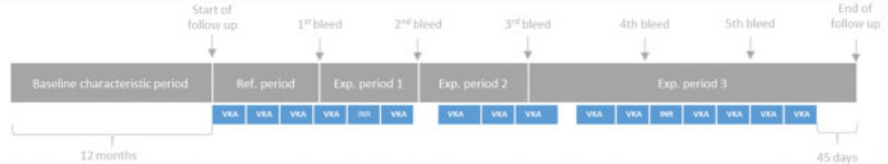
Fig. 1 Schematic description of study design. Individuals are followed up from their fi rst VKA prescription until discontinuation of VKA treatment (unless the study period ends, the individual leaves the database, or the individual dies before discontinuing treatment; not shown). In the analysis the risk of primary and secondary outcomes within each of exposure periods 1 to 3 (de fi ned by the number of bleeds that has occurred; 1, 2, or (cid:1) 3) was compared with the risk in the reference period (the period prior to the fi rst bleed under VKA treatment). Adjusted models include covariate information extracted from the baseline characteristic period (12-month period prior to the fi rst VKA prescription). VKA, vitamin K